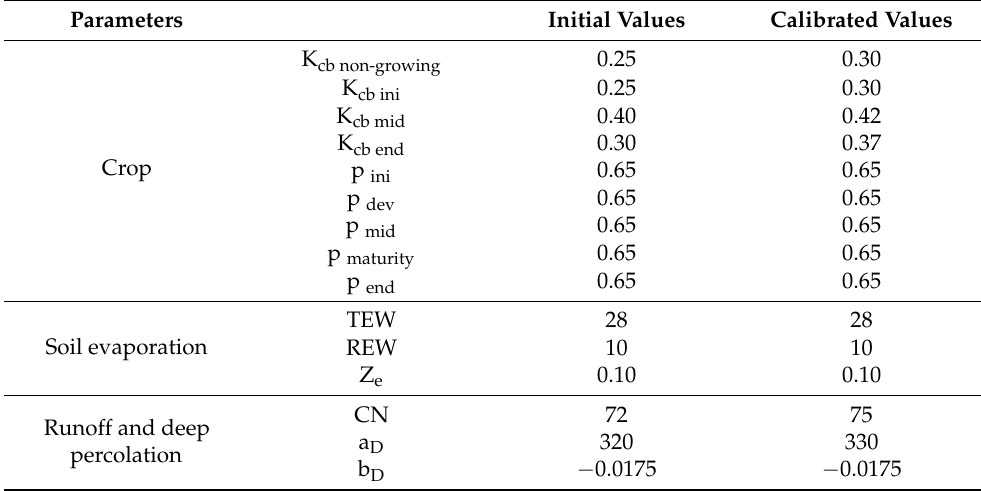
Table 3. Initial and calibrated parameters used in the SIMDualKc model.